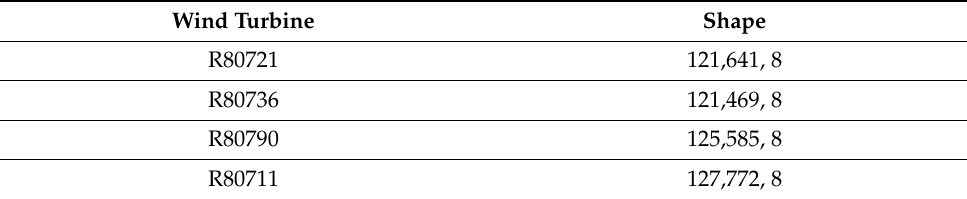
Table 11. Shape of Wind Turbine Dataset after Feature Selection by